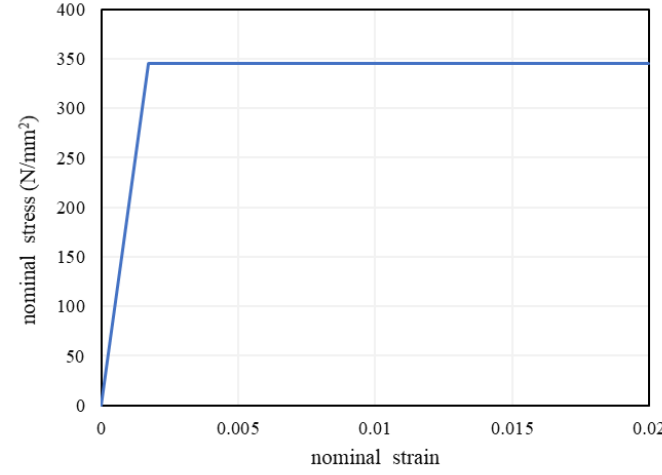
Figure 16. Stress−strain relationship of steel, converted to a single axis. Figure 16. Stress − strain relationship of steel, converted to a single